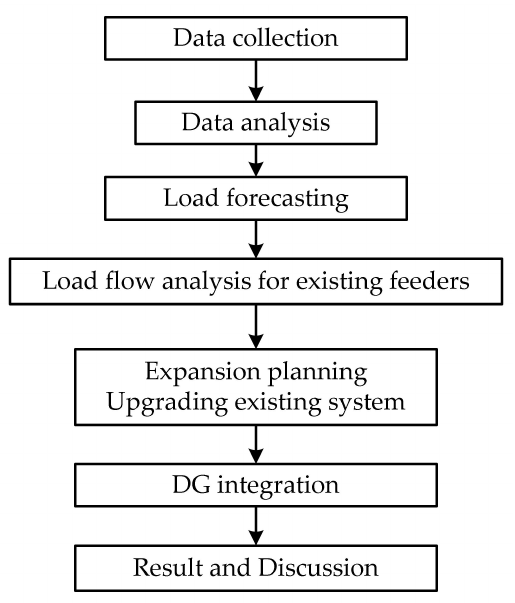
Figure 1. The Overall Methodology.